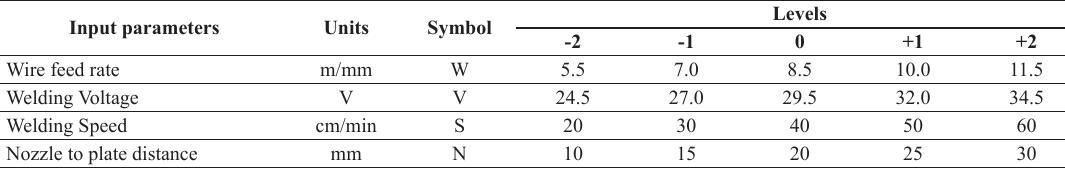
Table 1. Welding parameters and their levels.